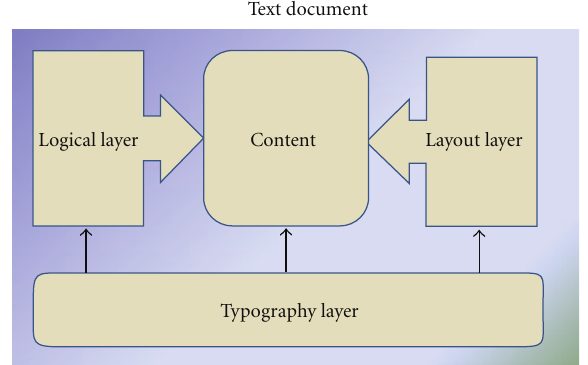
Figure 1: A general model of the text document